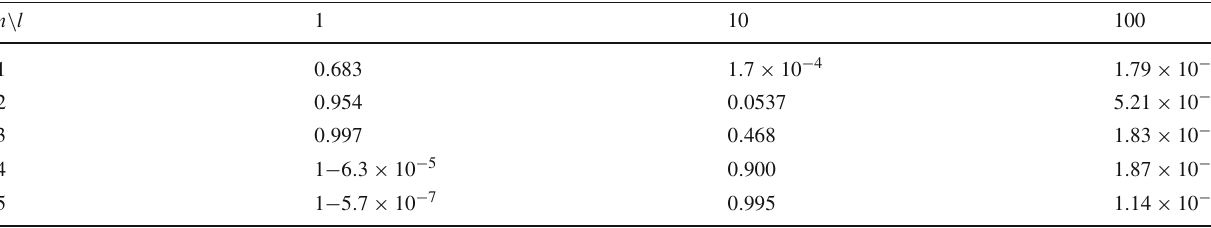
Fig. 16 Same as Fig. 14 but for the DNNLikelihood F 3 Table 6 Probability interval 1 − α corresponding to n σ for n = 1 , 2 , 3 , 4 , 5 in different dimension l = 1 , 10 ,